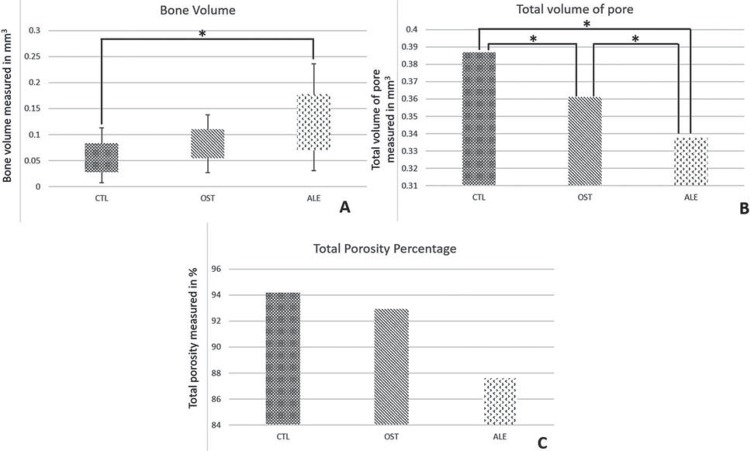
A- Graphic box-plot showing bone volume. CTL x OST x ALE: p>0.05. (*) p<0.05. B: Total volume of pore. p<0.05 (*). C: Total Porosity percentage. CTL x OST x ALE: p>0.05